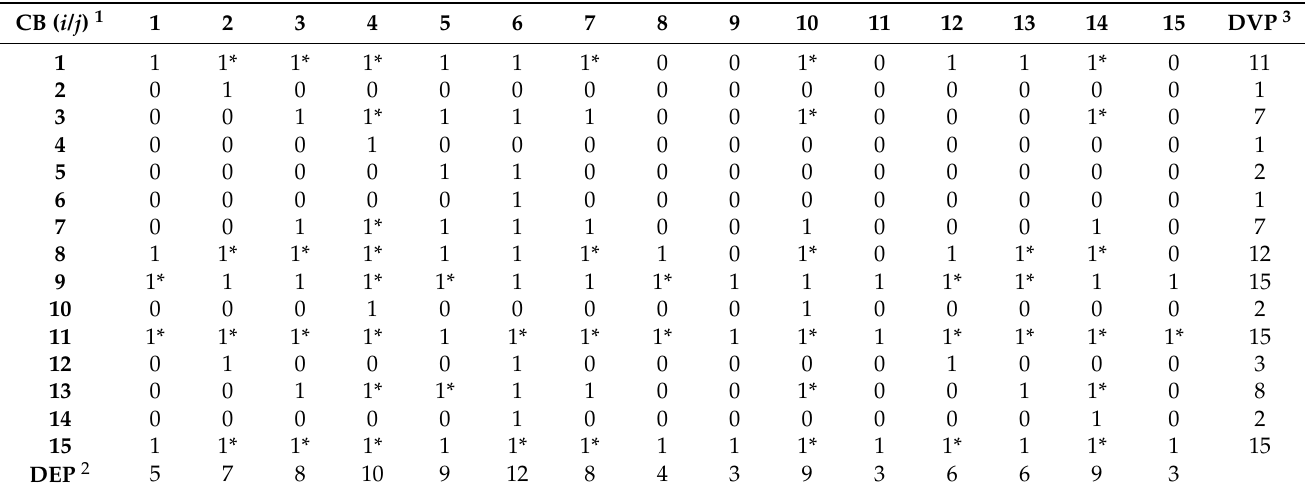
Table 6. Final Reachability